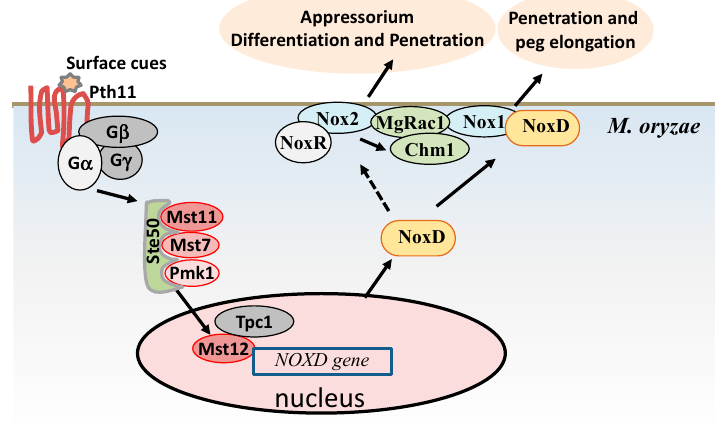
Figure 2. Model of NADPH oxidases-mediated appressorium formation and penetration in M. oryzae . The host surface cues are sensed by the G-protein coupled receptor, Pth11. After recognition of the cues, the G α subunit binds to GTP (guanosine triphosphate) and dissociates from the G βγ dimer and the induction of downstream MAPK (mitogen-activated protein kinase) cascades signaling occurs [21]. A component of the MAPK cascades signaling pathway, Mst12, interacts with the Zn(II) 2 Cys 6 transcriptional regulator, Tpc1, to regulate the expression of the orthologue of the P22 phox subunit ( NOXD ) of the NADPH oxidase complex. NoxD interacts with Nox1 and may be with Nox2 indirectly to control the elongation of the penetration peg. Both Nox1 and Nox2 interact with small GTPase, MgRac1, and may be regulated by MgRac1. In addition, the synthesis of ROS by the NoxR-Nox2 NADPH oxidase complex is required for the maintenance of the F-actin network and septin-dependent assembly of the exocyst at the appressorium pore to initiate plant